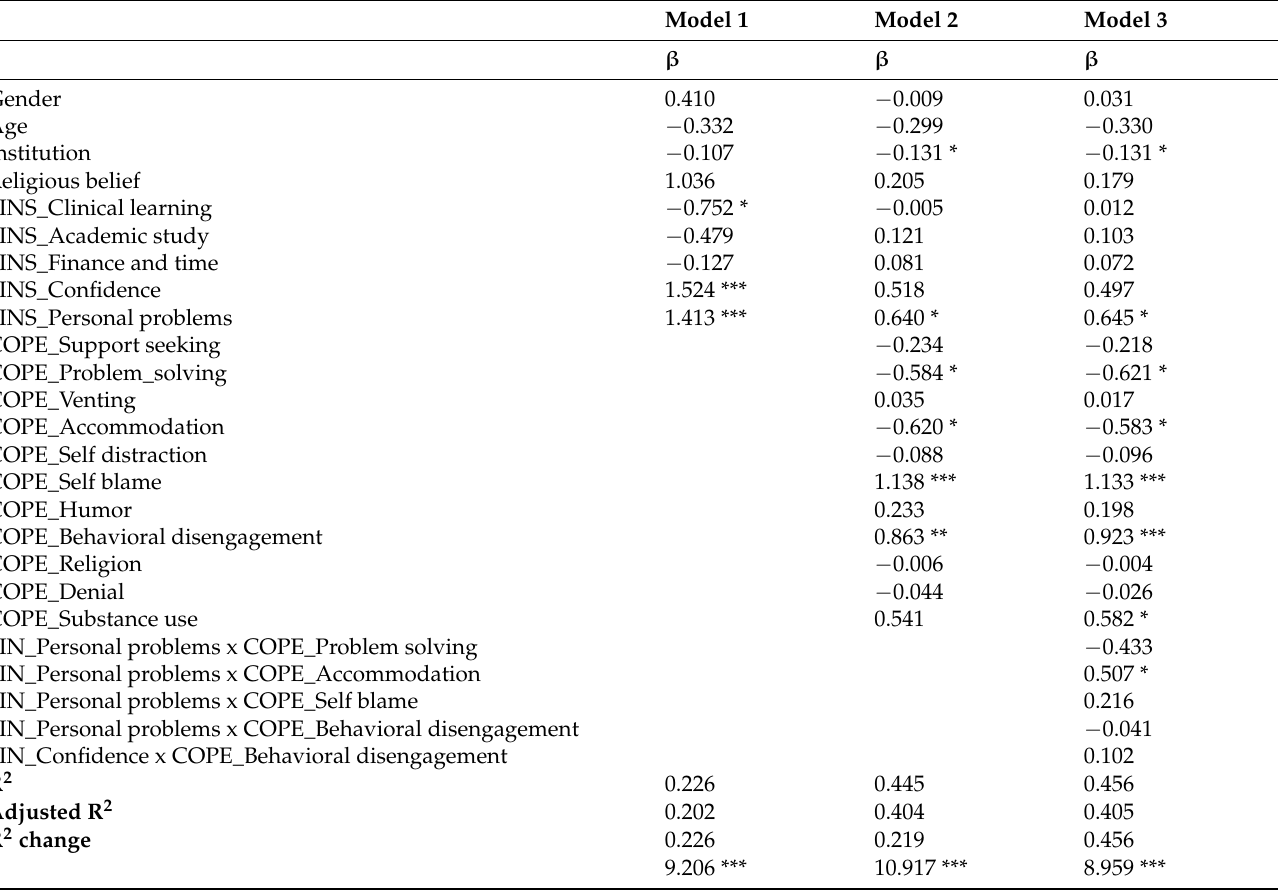
Table 3. Predictorsofstressorsandcopingonpsychologicalwell-beingusingmultiplehierarchicalregression.